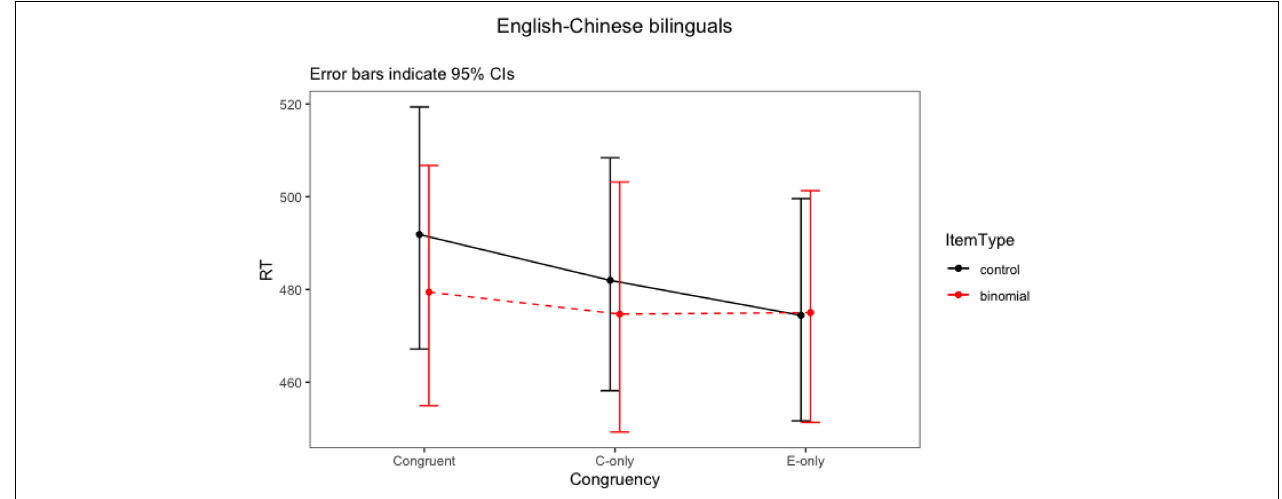
FIGURE 3 | Interaction plot of Item type * Congruency for English-Chinese bilinguals.